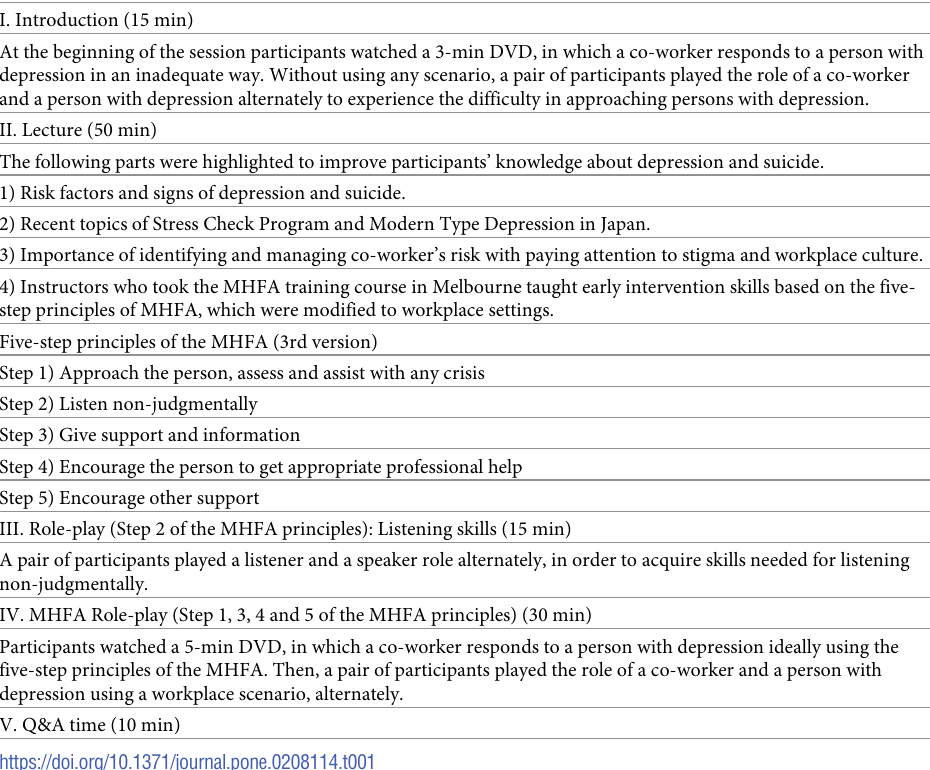
Table 1. 2-h educational program for early intervention in depression among office